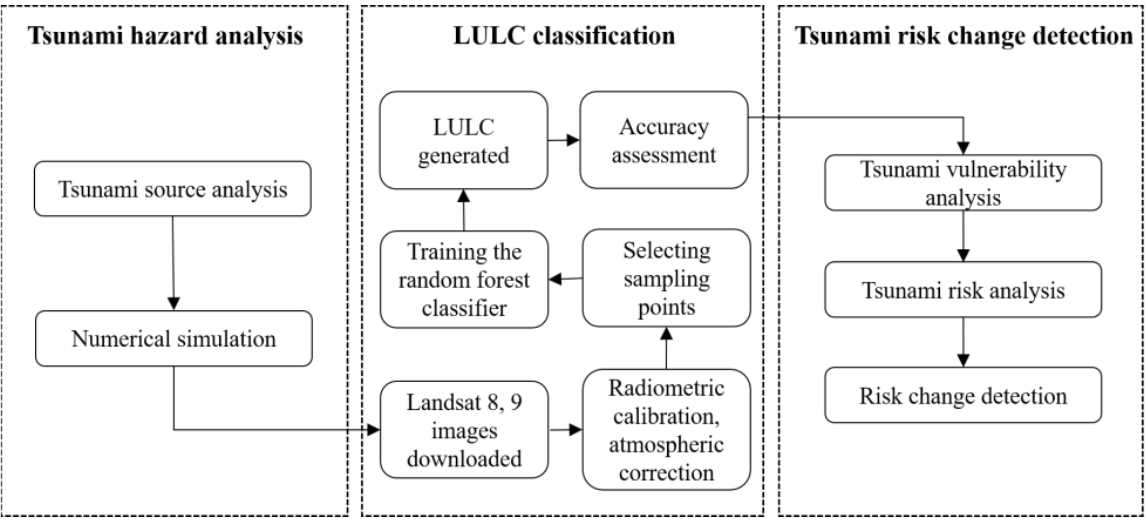
Figure 2. Overall flowchart of this study.